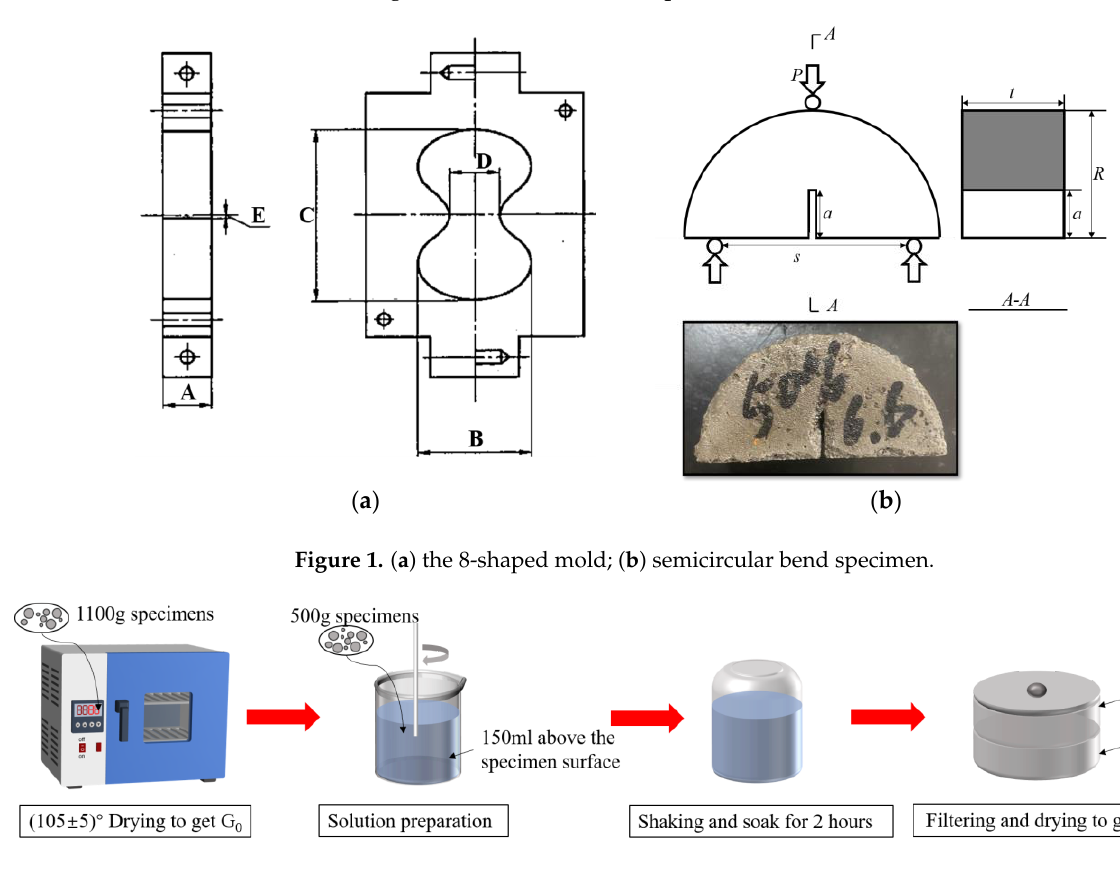
Figure 2. Clay content testing.